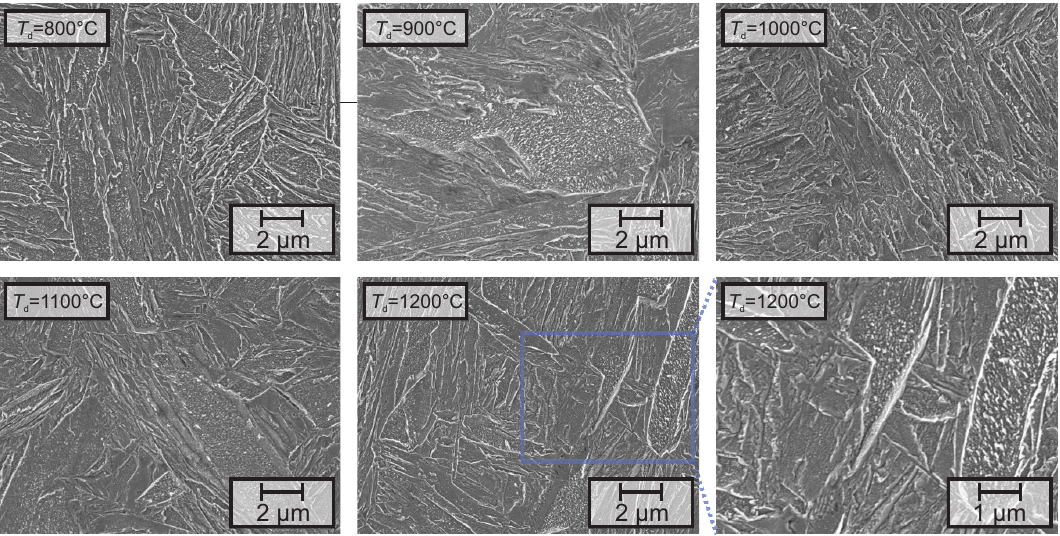
Figure 4. SEM-micrographs of lab-5, revealing the martensitic microstructure after different deformation temperatures ( T d ). Besides the martensitic laths, every sample shows regions with a high density of small precipitates, presumably